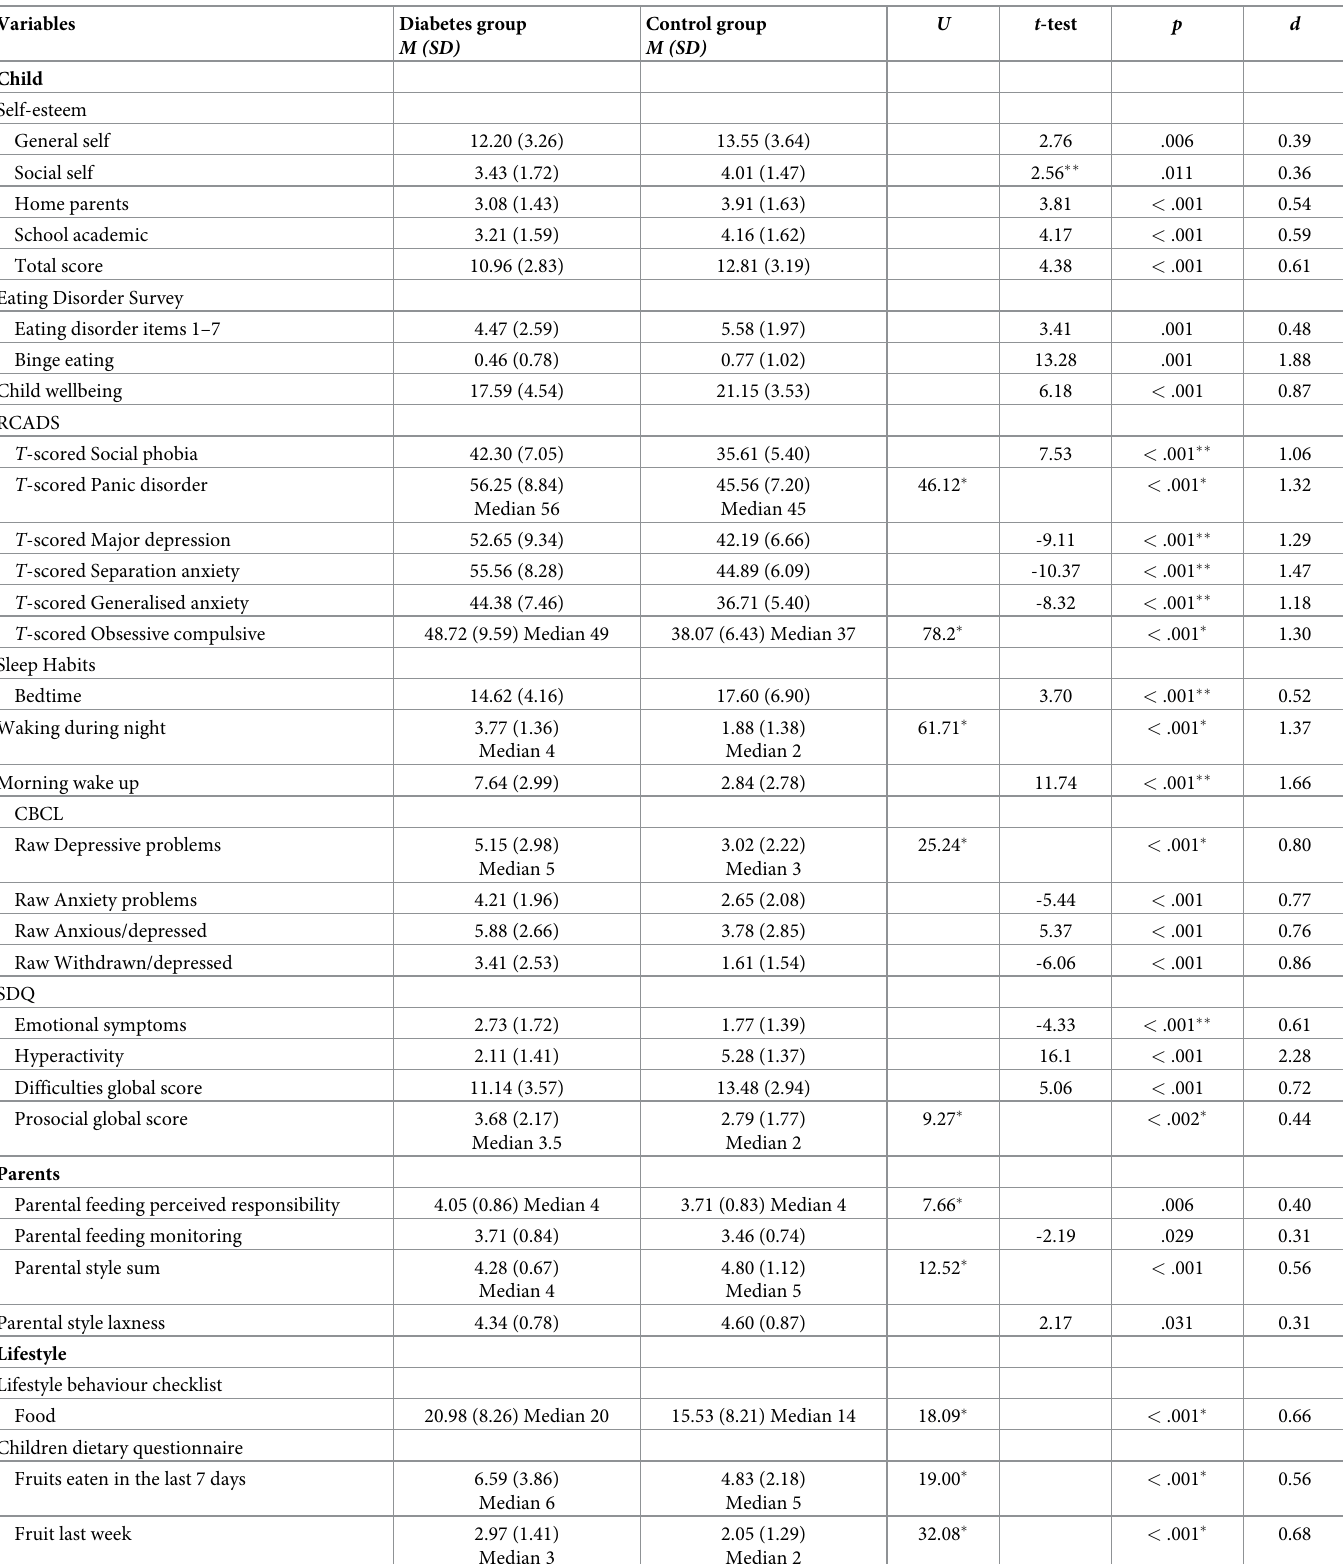
Table 12. Diabetes and control group differences on main study